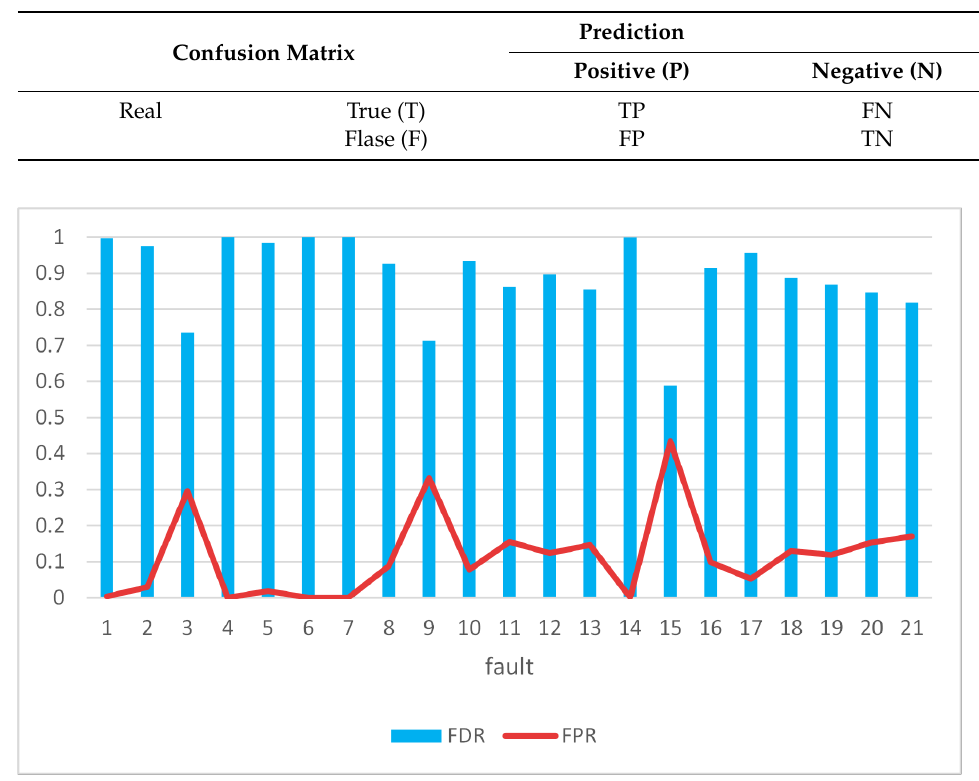
Figure 5. FDR and FPR of